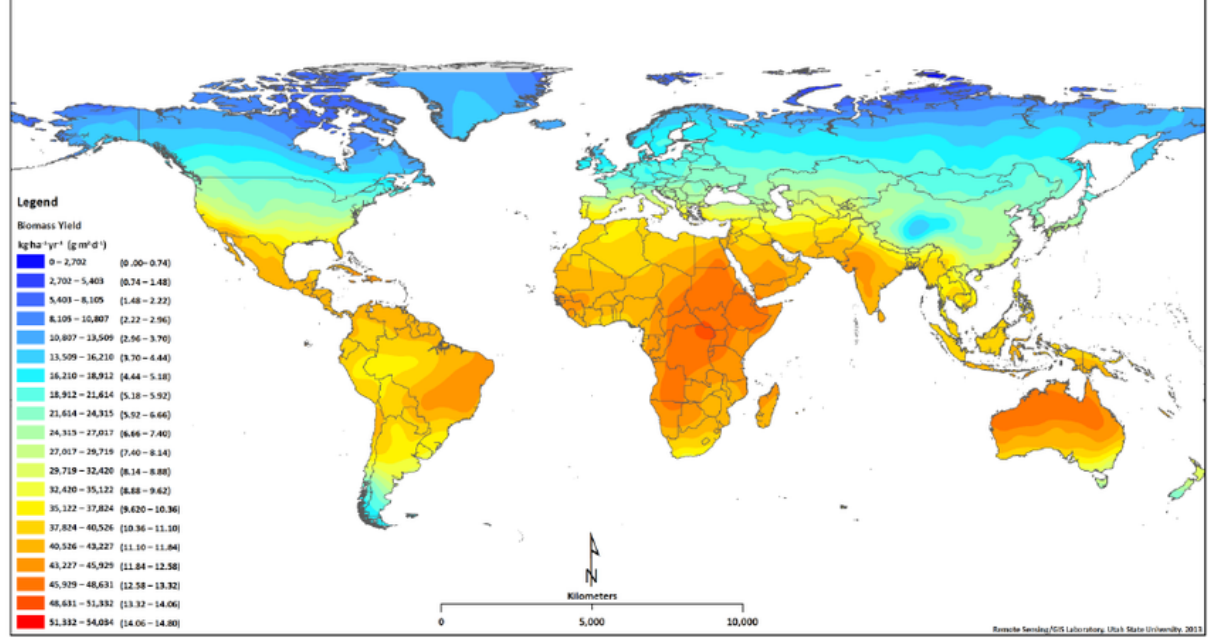
Fig. 7 : The world map of the potential biomass productivity from microalgae. Source: Moody and other, 2014, p.